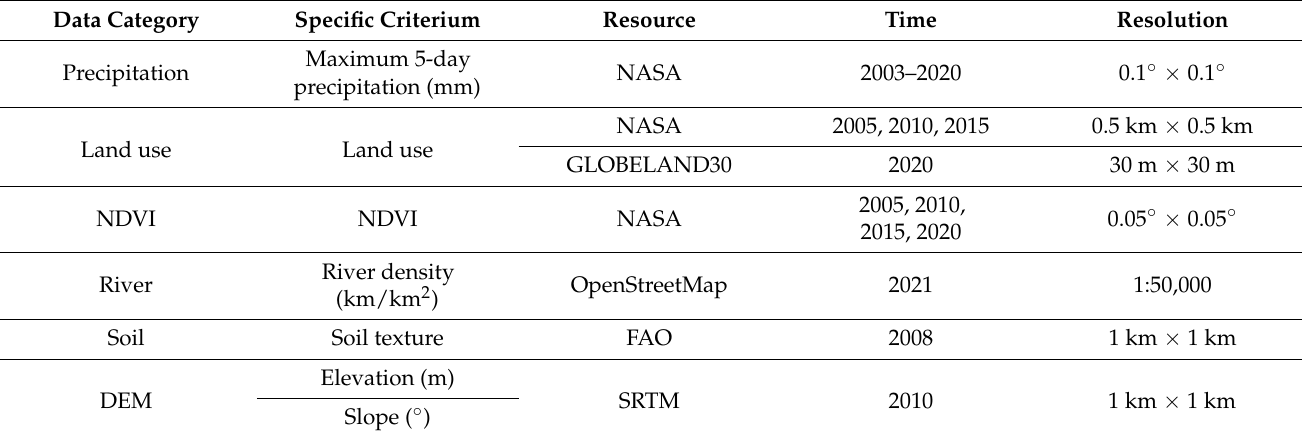
Table 1. Flood hazard data categories and